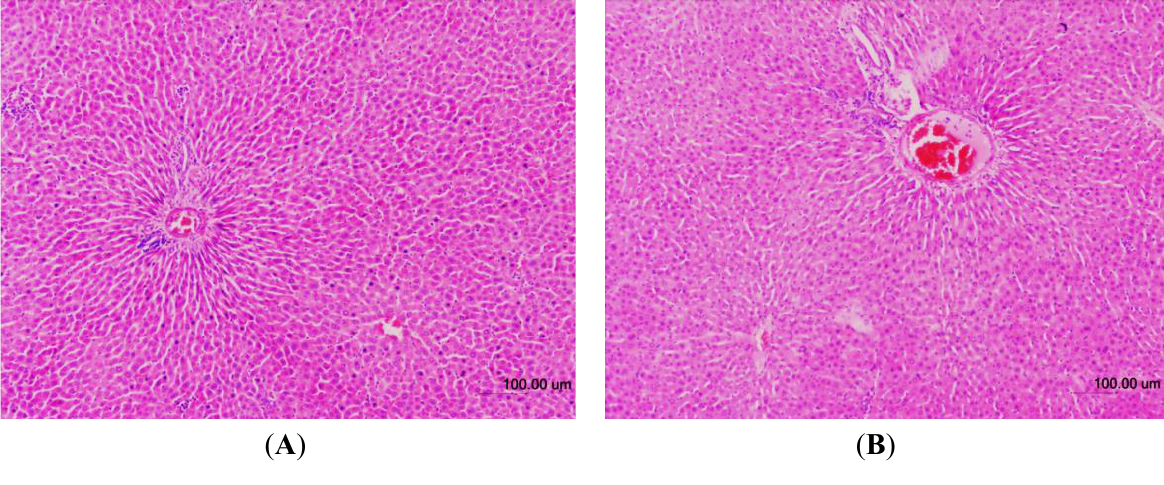
Figure 4. Hematoxylin and Eosin-stained sections of female liver tissues from control ( A ) and TQRFNE ( B ) treated groups. No significant damage was detected in both